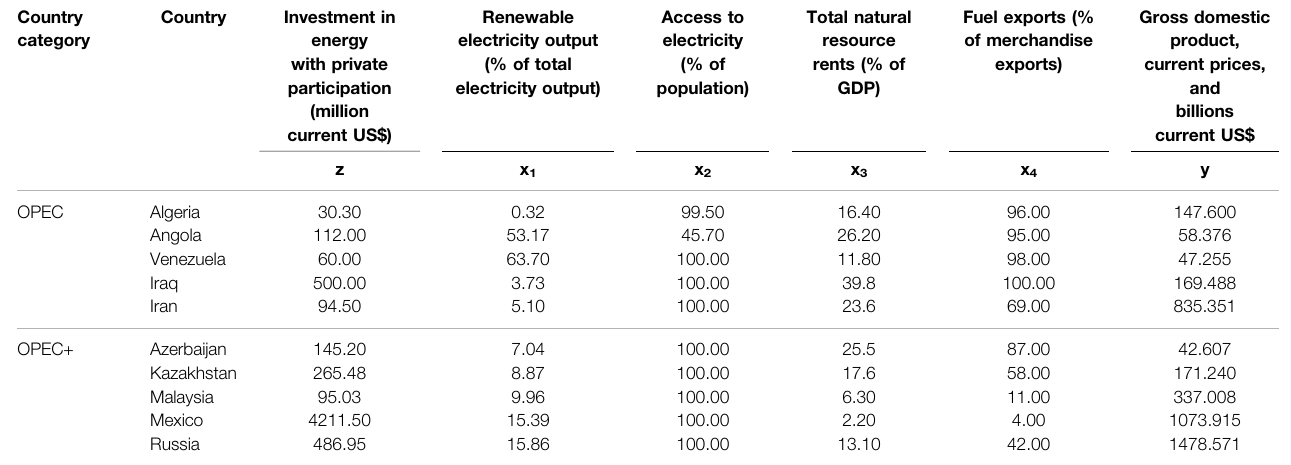
TABLE 1 | Statistics of energy economies in 2020. Country